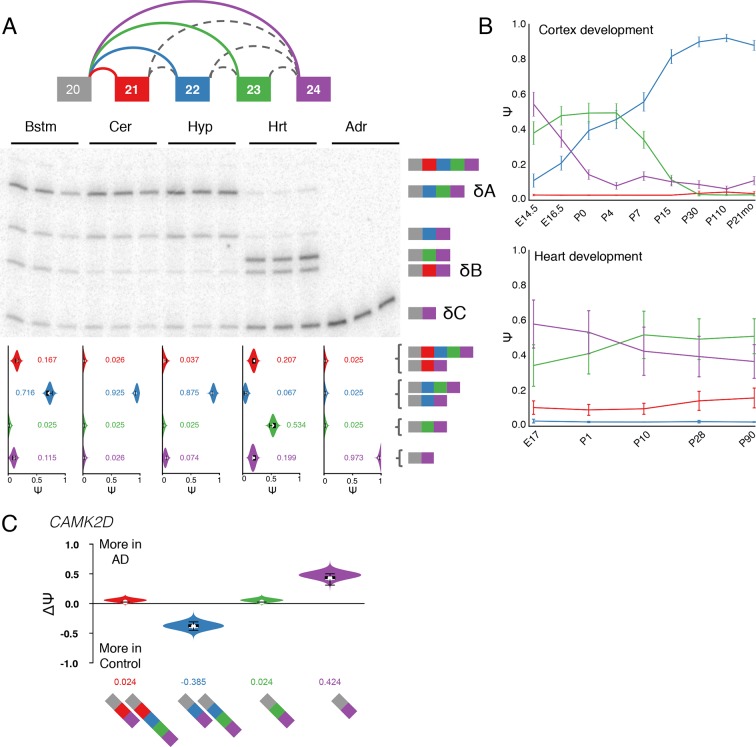
Camk2d LSV exhibits complex developmental dynamics and is
misregulated in Alzheimer’s disease.(A) Representation of complex source LSV in
Camk2d with matching RT-PCR validation in five
tissues (brainstem, cerebellum, hypothalamus, heart, and adrenal).
Colored arcs represent the junctions quantified by MAJIQ for this LSV
while dashed arcs correspond to junctions in the RNA-seq data that are
not part of the quantified LSV. Violin plots on the bottom display Ψ
quantifications (x-axis) for each of the colored junctions (y-axis)
across the five tissues with appropriate isoforms from the gel on the
right. Isoforms with known tissue-specific splicing patterns are labeled
as in the literature (B) Line graphs of MAJIQ E[Ψ]
quantification (y-axis) of junctions as in (A) across time
points (x-axis) through cortex development (top) and heart development
(bottom). Points represent mean Ψ and error bars represent one standard
deviation in E[Ψ]. (C) ΔΨ quantification comparing changes
between control and Alzheimer’s patient brains of the homologous
junctions illustrated in (A).